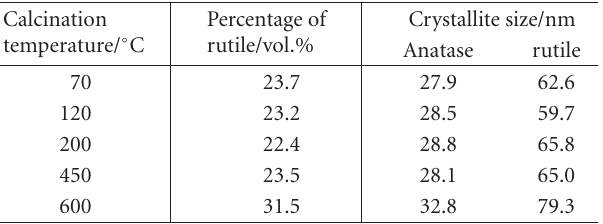
Table 1: Composition and crystallite sizes calculated from the XRD data for 1wt.% Ag-TiO 2 photocatalysts.